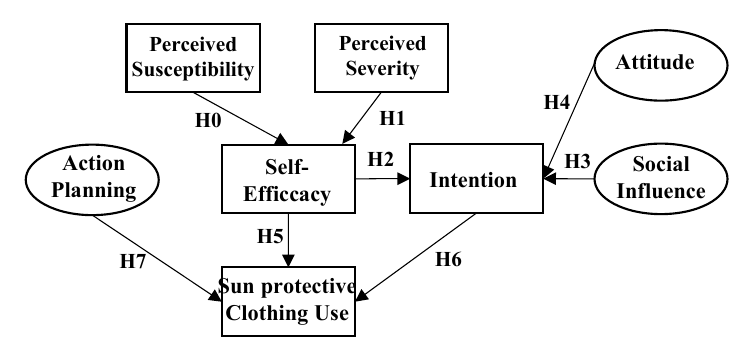
Figure 1. Proposed model for the UV textile usage.